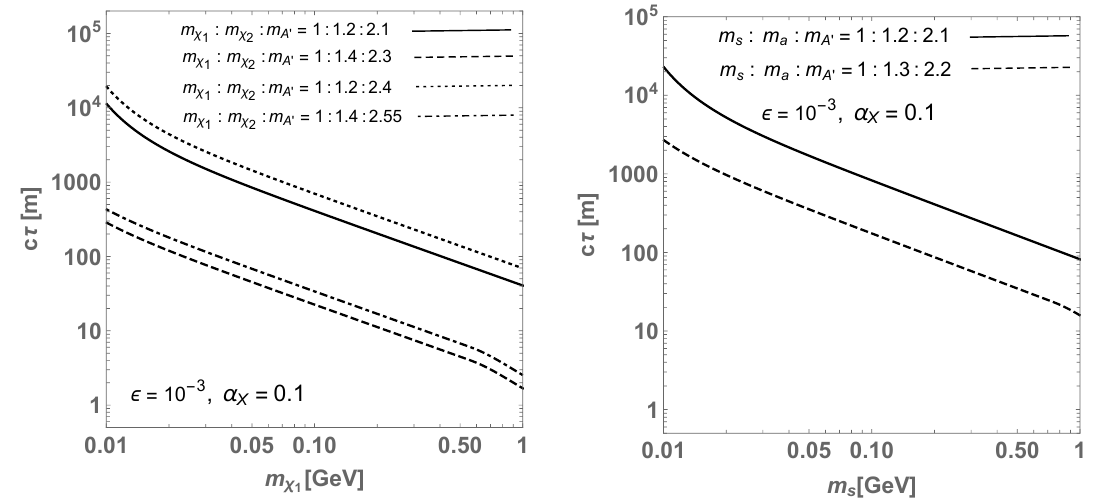
and m given in the left and right s 1